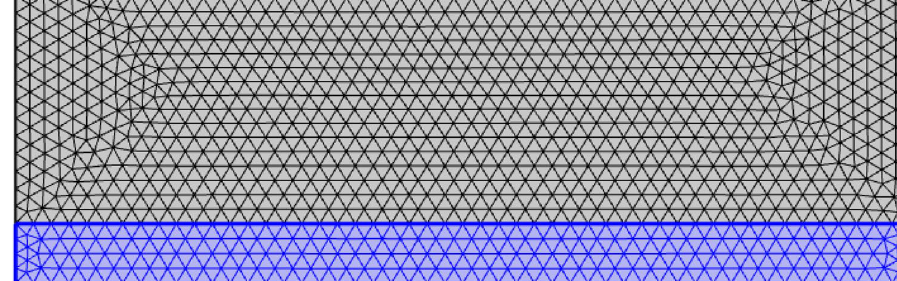
Fig. 2 Simplified diagram of relative position between igneous rock and surrounding rock Fig. 3 Grid division of 2D simulation model (taking model 1 as an example)